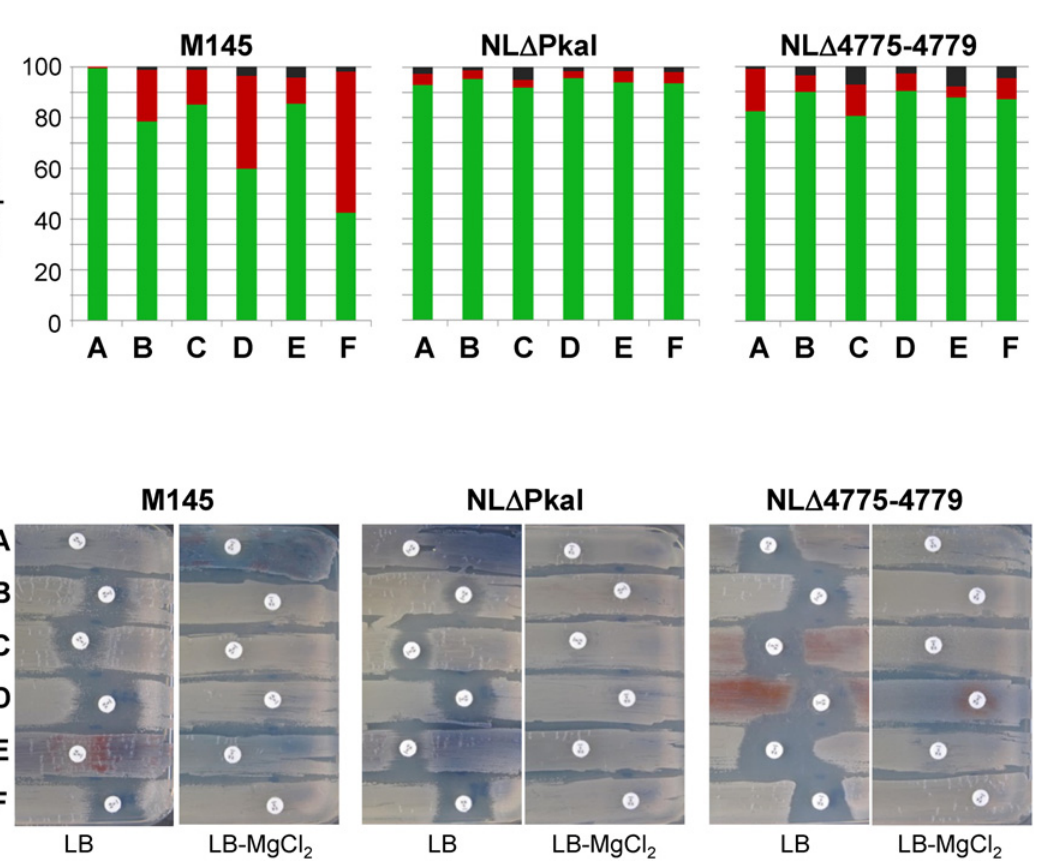
Fig 3. Effect of Ser/Thr kinases on the viability of spores (A) and the resistance of germinating spores to vancomycin (B). Spore chains were stained with the LIVE/DEAD BacLight Bacterial Viability Kit (Molecular Probes) and observed by fluorescence microscopy. Percentage of viable (green), dead (red) and spores without DNA (black) is given for each strain. Spores of the different strains were plated onto LB agar and filter discs containing 5 μ g vancomycin were applied. Whereas, M145 and the pkaI mutant NL Δ PkaI were resistant, NL Δ 4775 – 4779 spores showed vancomycin sensitivity, suggesting an impaired spore wall. Vancomycin sensitivity of M145 or NL Δ PkaI was also caused by expressing a second copy of each kinase gene, with the exception of pkaI . Supplementation of the agar plates with 3 mM MgCl 2, known to rescue mutants impaired in cell wall synthesis restored vancomycin resistance to all strains. A, no plasmid integrated; B, :: pSET152-pkaH; C, :: pSET152-SCO4776; D, :: pSET152-pkaD; E, :: pSET152-pkaI; F, ::